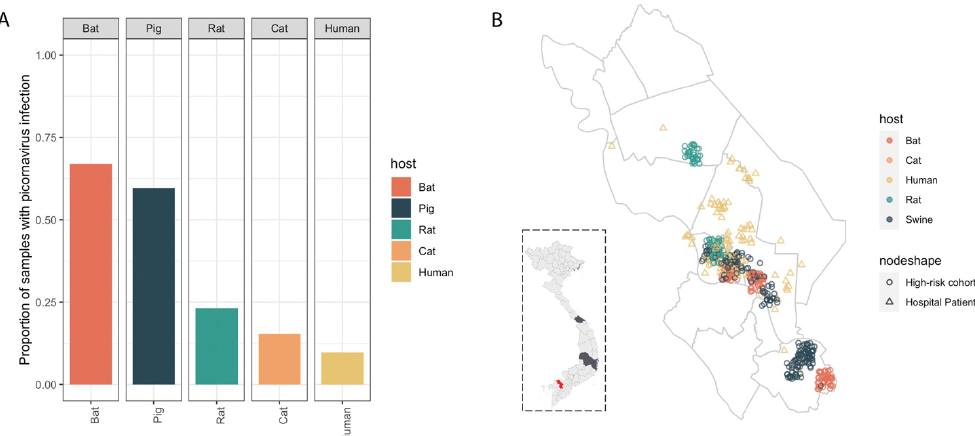
Figure 1. Prevalence of picornavirus contigs by host. ( A ) Proportion of samples with picornavirus sequences detected in each host type. ( B ) Samples with picornavirus sequences identified in Dong Thap province (highlighted in red in dashed square). Symbol colours indicate host (used consistently in all figures), and for human samples symbol shape indicates those from the risk cohort study (circles) and hospital patients (triangles).